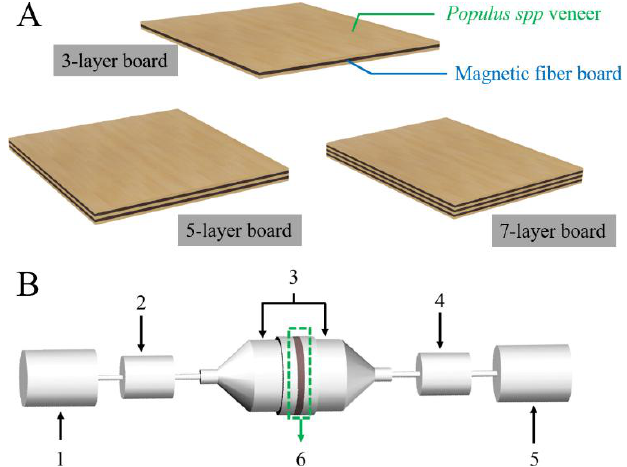
Figure 1. ( A ) Schematic diagram of the three different magnetic fiber multi-layer board. ( B ) The experimental components the network analyzer: 1. EMW generator; 2. attenuator; 3. specimen holder; 4. attenuator; 5. EMW receiving terminal; 6. test